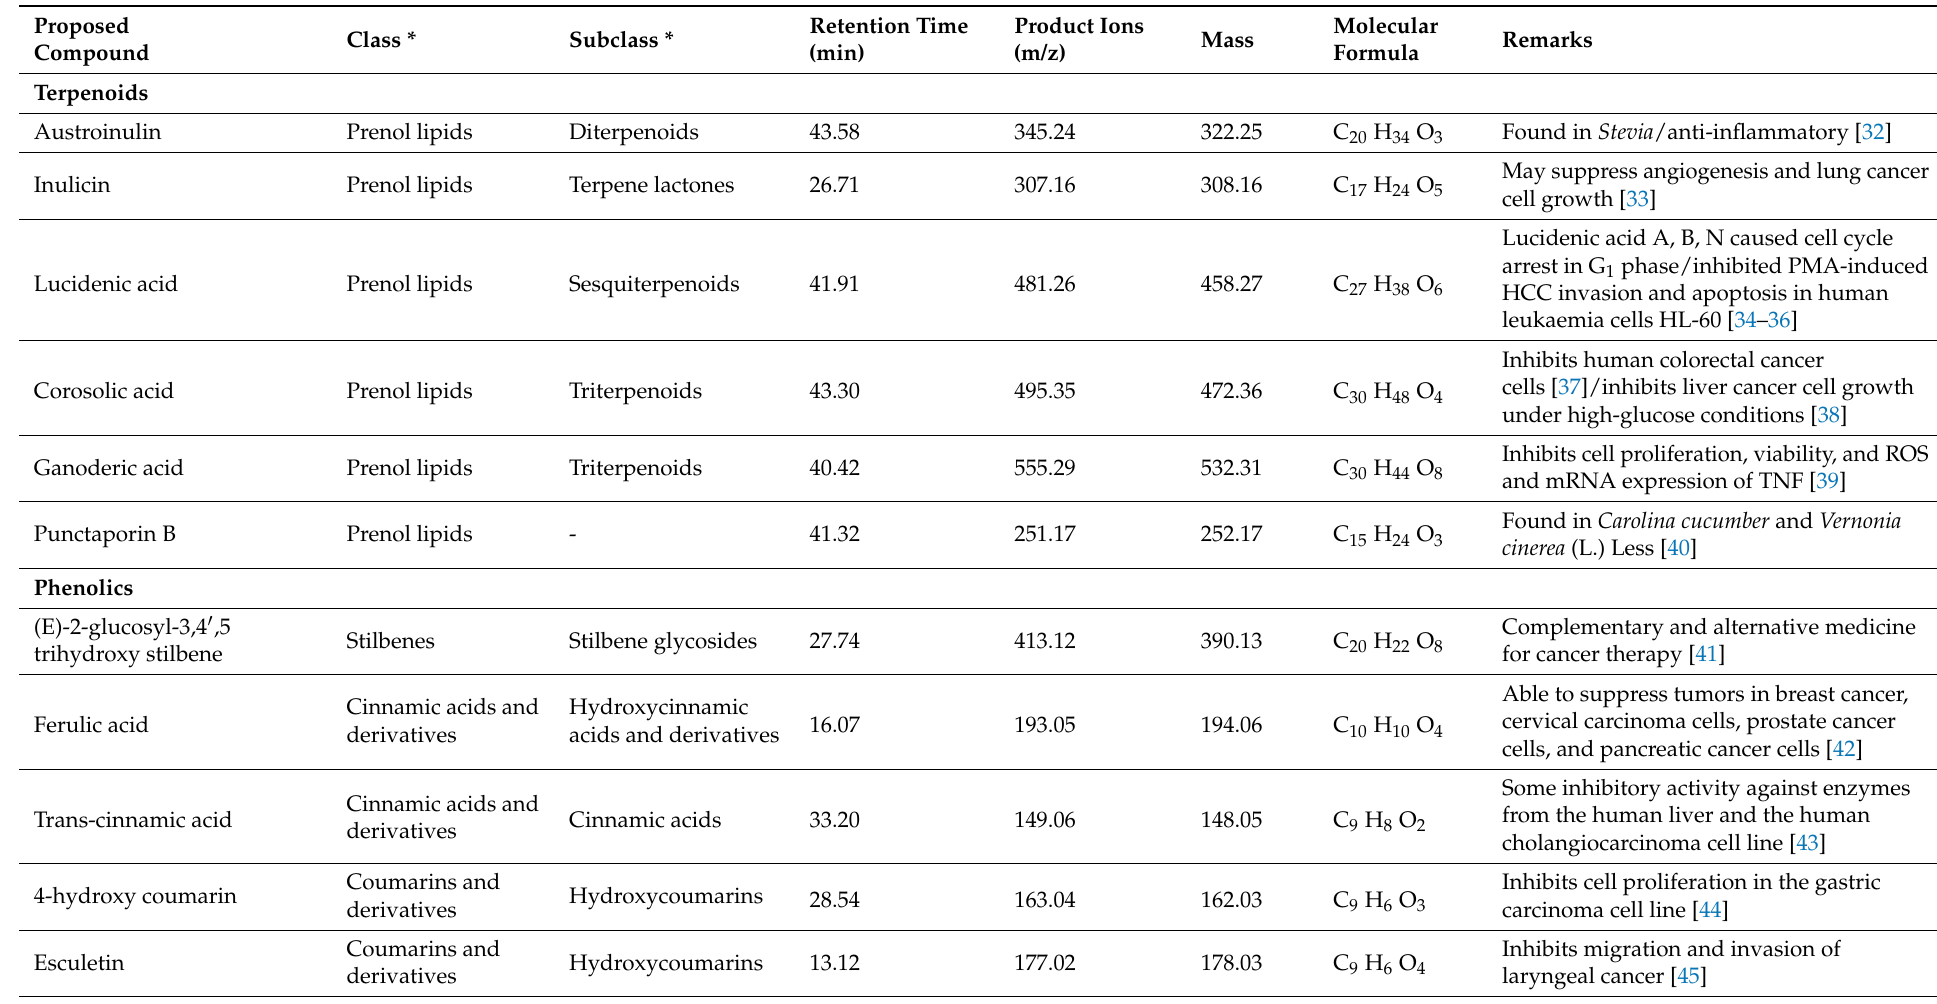
Table 2. A list of metabolites in R. nasutus leaf